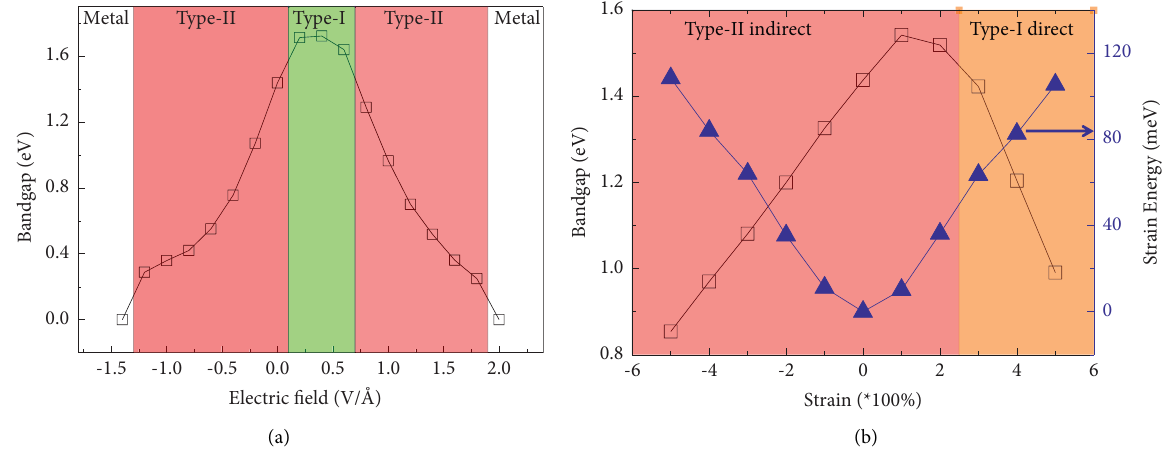
Figure 6: Te CTF/As vdWhs bandgaps versus the (a) electric felds and (b) axial strain.